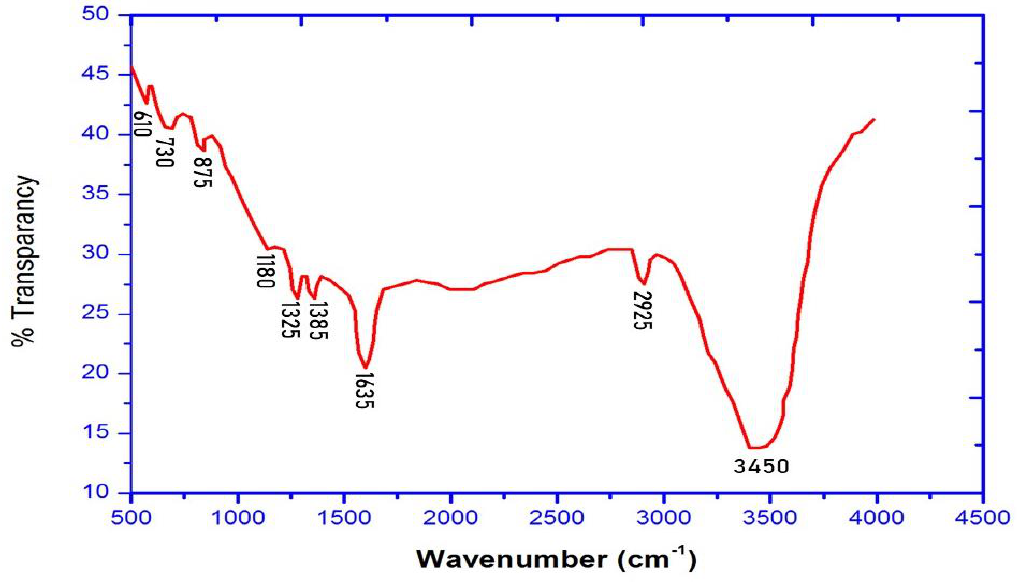
Figure 7. FTIR spectrum of